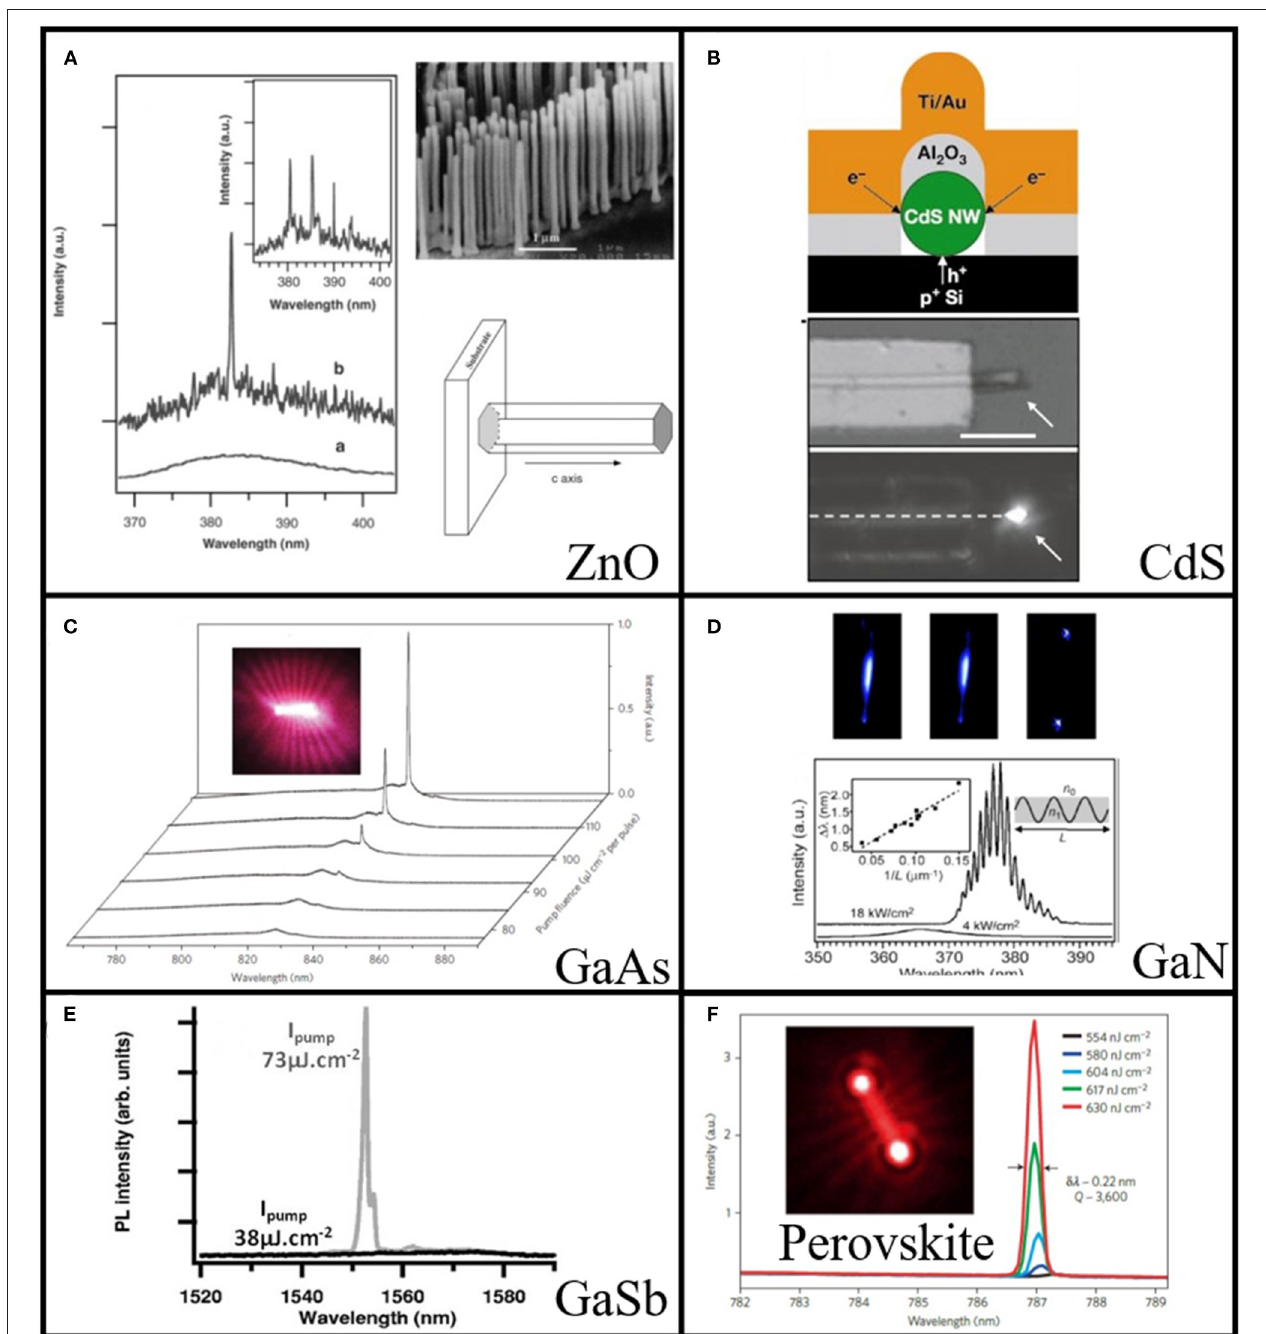
FIGURE 4 | (A) Emission spectra from ZnO nanowire arrays below (line a) and above (line b and inset) the lasing threshold. The pump power for these spectra are 20, 100, and 150 kW cm − 2 , respectively. Upper right panel: the SEM image of the as-synthesized ZnO nanowire, scale bar:1 µ m. Lower right panel: schematic illustration of a nanowire as a resonance cavity with two naturally faceted hexagonal end faces acting as reflecting mirrors. (B) Upper panel: schematic of electrically driven nanowire lasers made of CdS. Lower panel: SEM image and electroluminescence image of the device. Scale bar: 5 µ m. (C) GaAs nanowire emission spectra with increasing pump fluence around threshold and optical image of nanowire above threshold (inset). (D) Upper panel: optical images of the single GaN nanowire at 4, 17, and 66 kW cm − 2 (from left to right). Lower panel: PL spectra of the GaN nanowire under excitation of 4 and 18 kW cm − 2 . Left inset: mode spacing as a function of inverse nanowire length. Right inset: schematic representation of a longitudinal nanowire cavity. (E) PL spectra of GaSb nanowire laser below (38 µ J cm − 2 ) and above (73 µ J cm − 2 ) threshold. (F) Spectra evolution of single MAPbI 3 nanowire around lasing threshold. Inset shows the fluorescence image above threshold. (A) Reproduced with permission. Huang et al. (2001) Copyright 2001, American Association for the Advancement of Science. (B) Reproduced with permission. Duan et al. (2003) Copyright 2003, Nature Publishing Group. (C) Reproduced with permission. Saxena et al. (2013) Copyright 2013, Nature Publishing Group. (D) Gradeˇcak et al. (2005) Copyright 2005, American Institute of Physics. (E) Reproduced with permission. Chin et al. (2006) Copyright 2006, AIP Publishing LLC. (F) Reproduced with permission. Zhu et al. (2015) Copyright 2015, Nature Publishing Group.